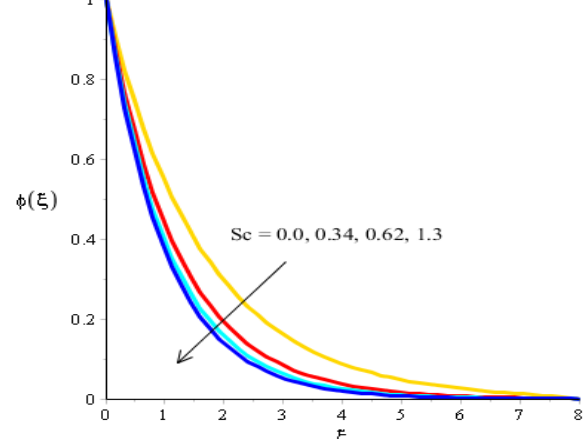
Figure 13. Analysis of concentration curves versus S c .